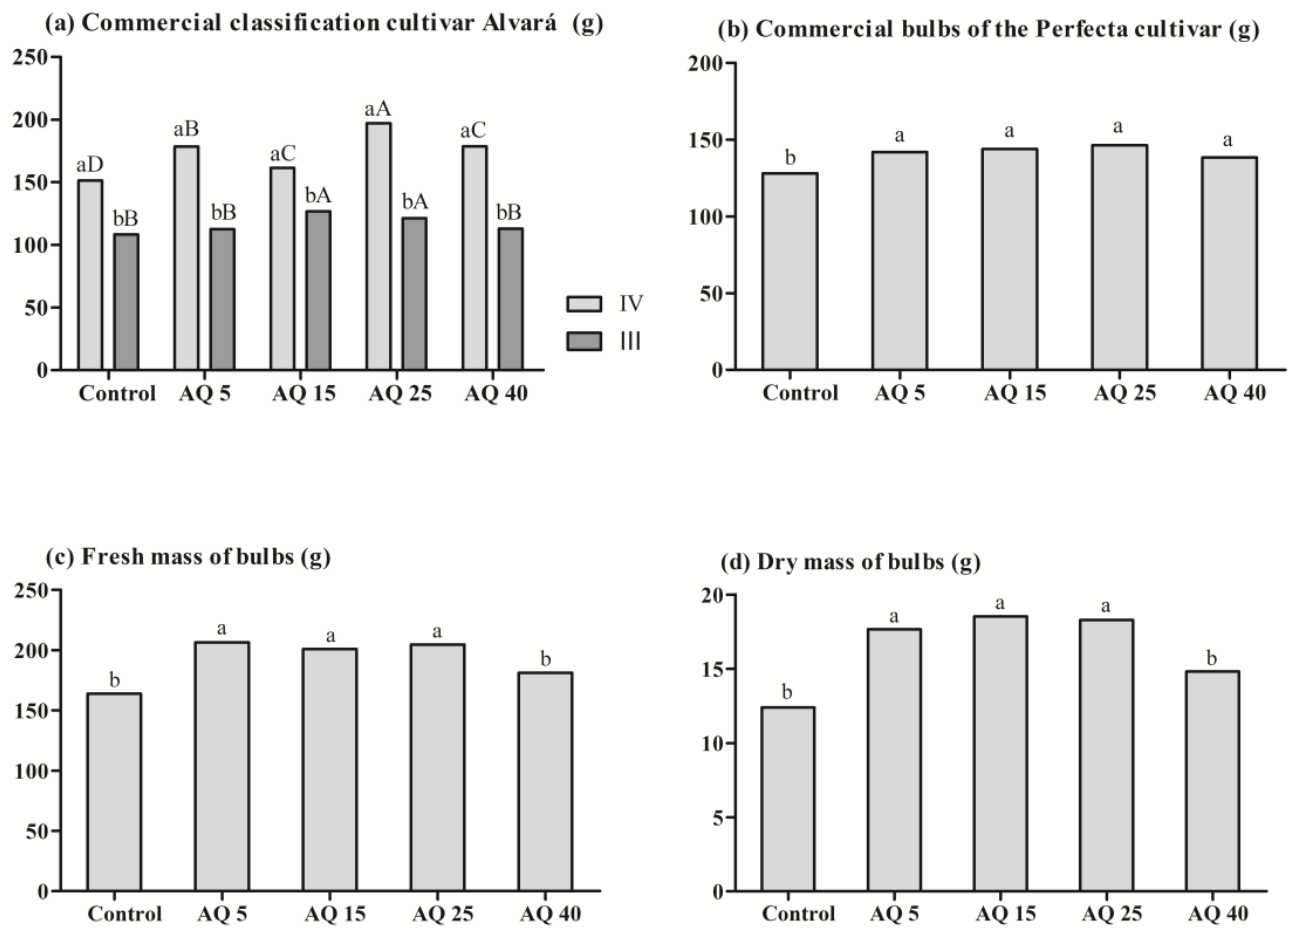
Figure 3. Classification of class III and IV bulbs of the Alvar á onion cultivar ( a ), average classification of class III and IV bulbs of cultivar Perfecta ( b ), fresh mass of bulbs of the Alvar á and Perfecta cultivars ( c ), dry mass of bulbs of the Alvar á and Perfecta cultivars ( d ) submitted to foliar applications of biomass suspensions of the microalgae A. quadricellulare at different concentrations. Treatments: 0 g L − 1 (control); 0.05 g L − 1 (AQ 5); 0.15 g L − 1 (AQ 15), 0.25 g L − 1 (AQ 25); 0.4 g L − 1 (AQ 40). Class = IV and III. Columns with the same letter do not differ statistically ( p < 0.05) by Tukey’s test ( n = 4). Capital letters = foliar treatments. Lower-case letters =